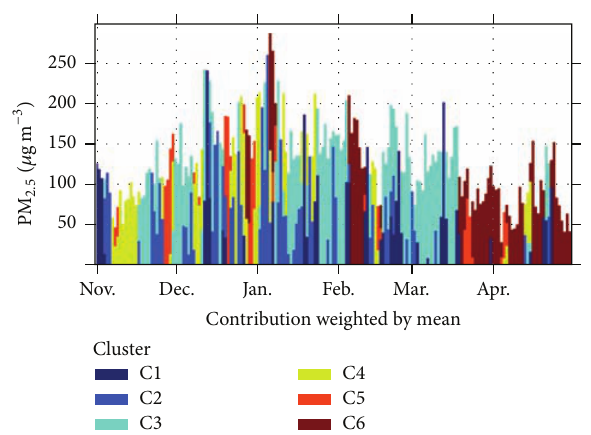
Figure 6: Temporal variation in daily PM 2.5 concentrations at the Gazipur station shown by contribution of each cluster.